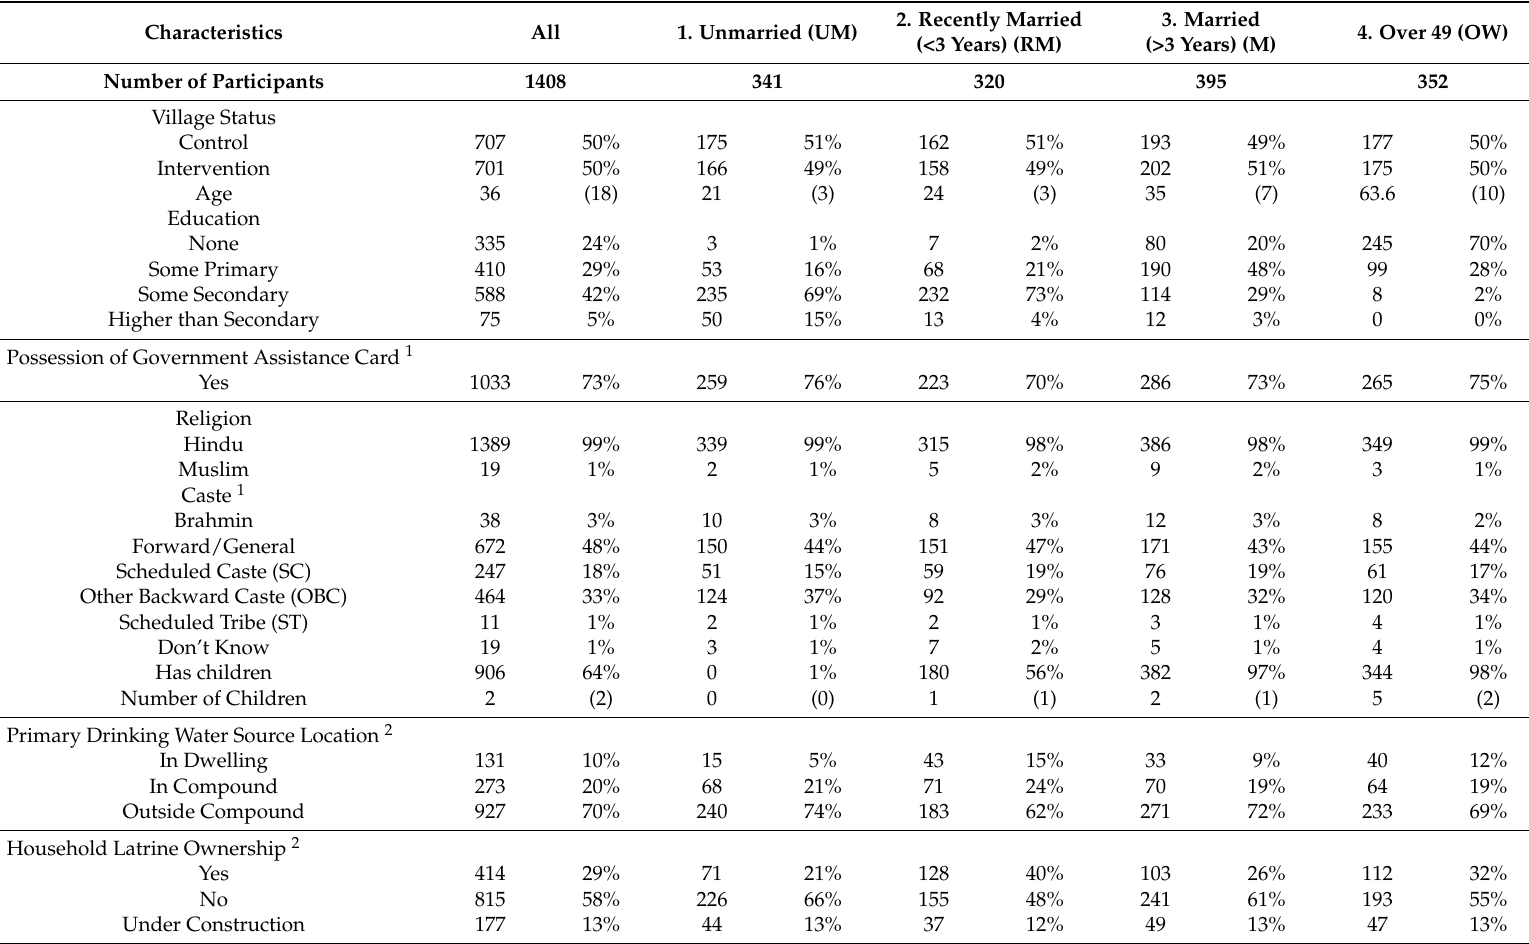
Table 1. Demographic characteristics of survey participants, overall and by life stage in Rural Orissa, India (N = 1408).